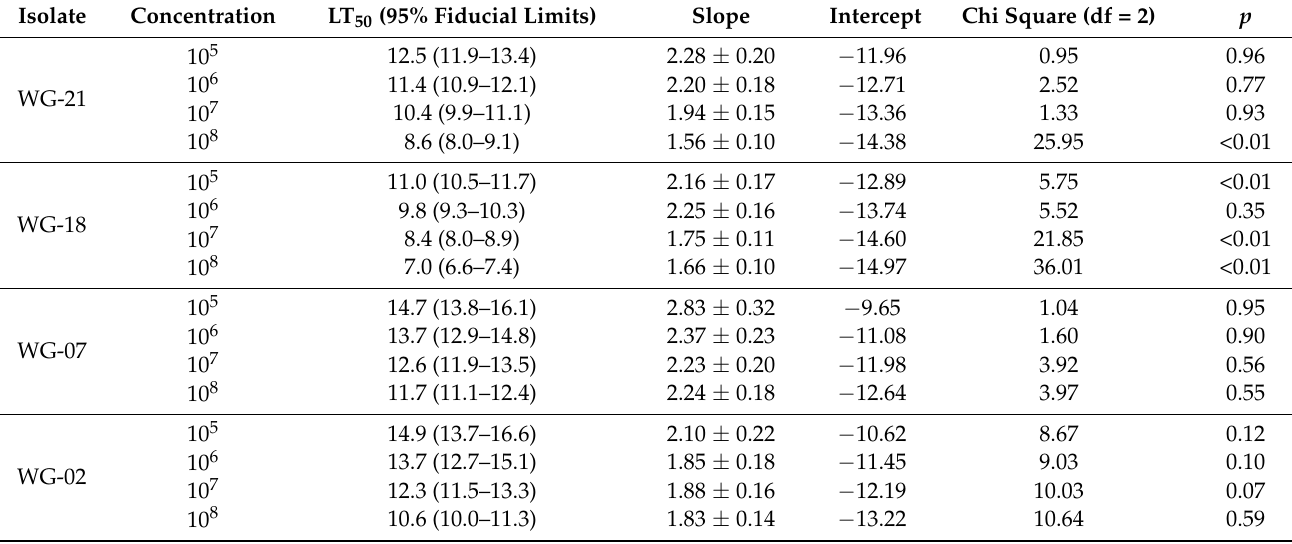
Table 4. Probit analysis estimates of lethal time (days) required to kill 50% (LT 50 ) of adult of B. zonata along with their 95% fiducial limits. p value represents the goodness of fit test. Isolate